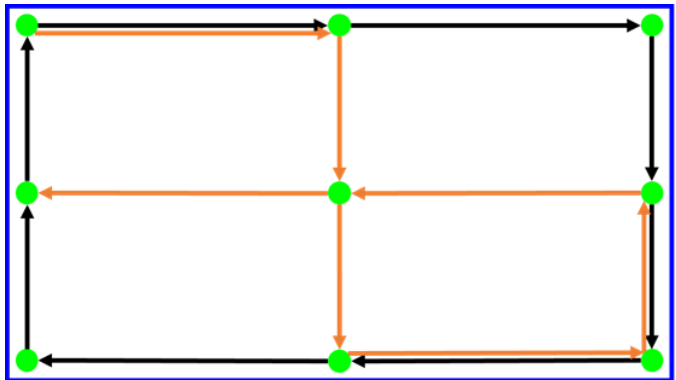
Figure 48. Integrated calibration diagram.